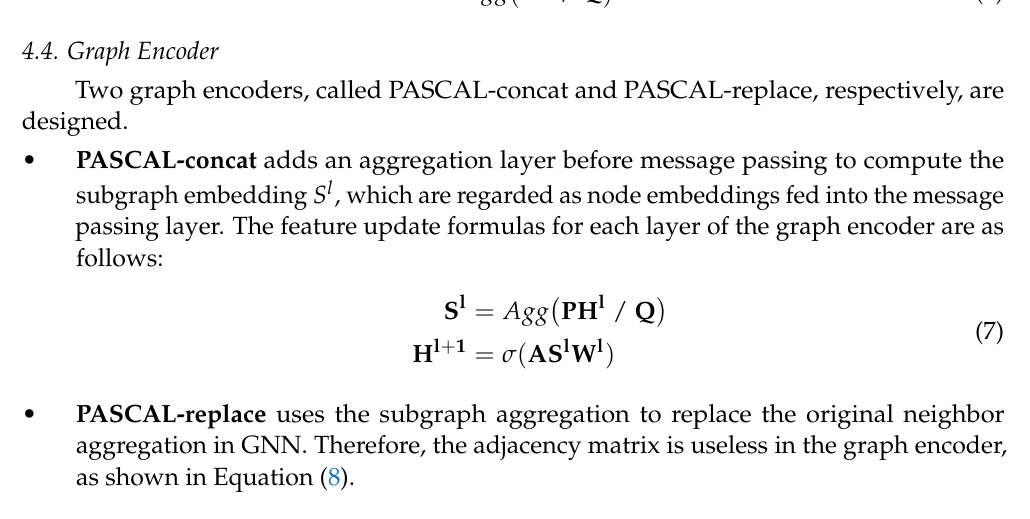
Figure 4. The process of calculating the triangle motif’s prototype of v i . m i motif containing the target node v i . m i motif prototype, respectively. “Sum” and “Mean” represent the computation of motif embedding and motif prototype using the su aggregator and mean aggregator,